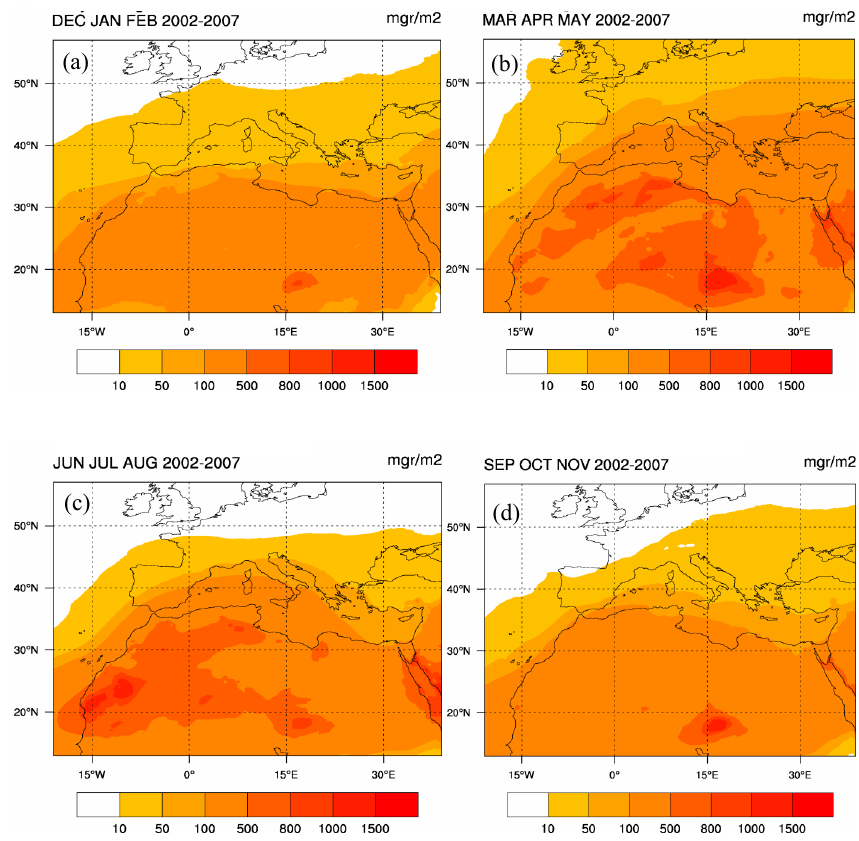
Fig. 8. Dust load as averaged during the 6-year period for the different seasons of the year, namely (a) winter, (b) spring, (c) summer and (d)